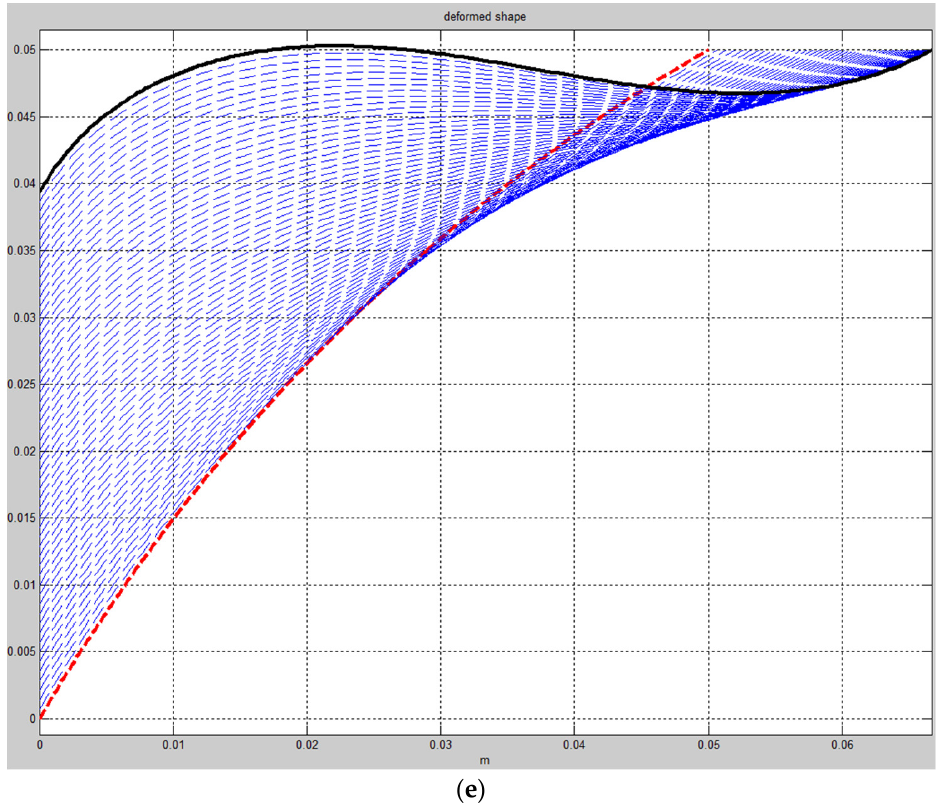
Figure 7. Graphs of the rod deformation axis: ( a ) Beginning process; ( b ) Quarter process; ( c ) Half process; ( d ) Three-fourths process; ( e ) End process.